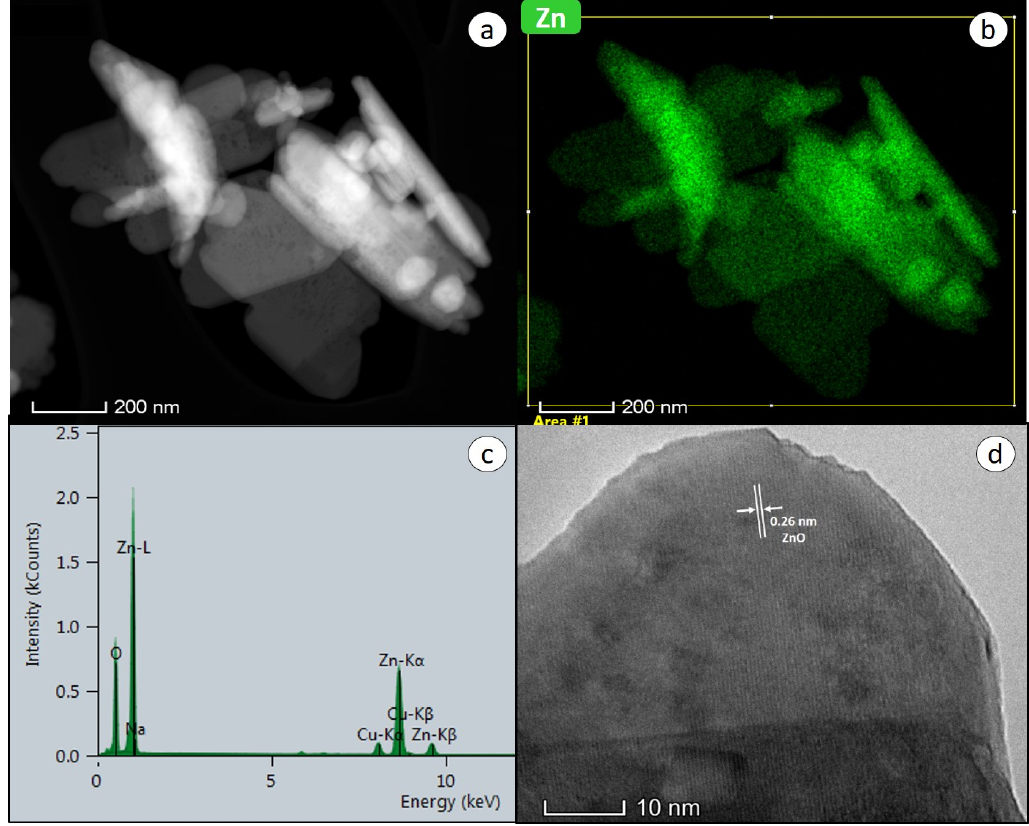
Figure 4. ( a ) Sample ZnO HAADF-STEM image. ( b ) energy-dispersive X-Ray spectroscopy (XEDS) elemental map showing the spatial distribution of Zn corresponding to the area displayed in a . ( c ) energy-dispersive X-ray (XED) spectra of the area marked in b . ( d ) HRTEM image. The analysis of the cerium-modified samples by STEM-XEDS shows analogous results for the specimens with 1%, 2% and 3% cerium so that they are described together for simplicity. When acquiring a map of an area in which both sheets and nanoparticulate aggregates are observed in the high-angle annular dark field-scanning transmission electron microscopy (HAADF-STEM) image, such as those shown in Figures 5a, 6a and 7a, the corresponding maps show that the sheets are rich in Zn (displayed in green on the maps) and the nanoparticulate aggregates are rich in cerium (displayed in red on the maps). Figures 5b–d, 6b–d and 7b–d show the maps of Ce, Zn and the combination of both elements for the samples with 1%, 2% and 3% cerium, respectively. Once the maps were acquired it was possible to extract the sum spectrum of all the spectra acquired in each of